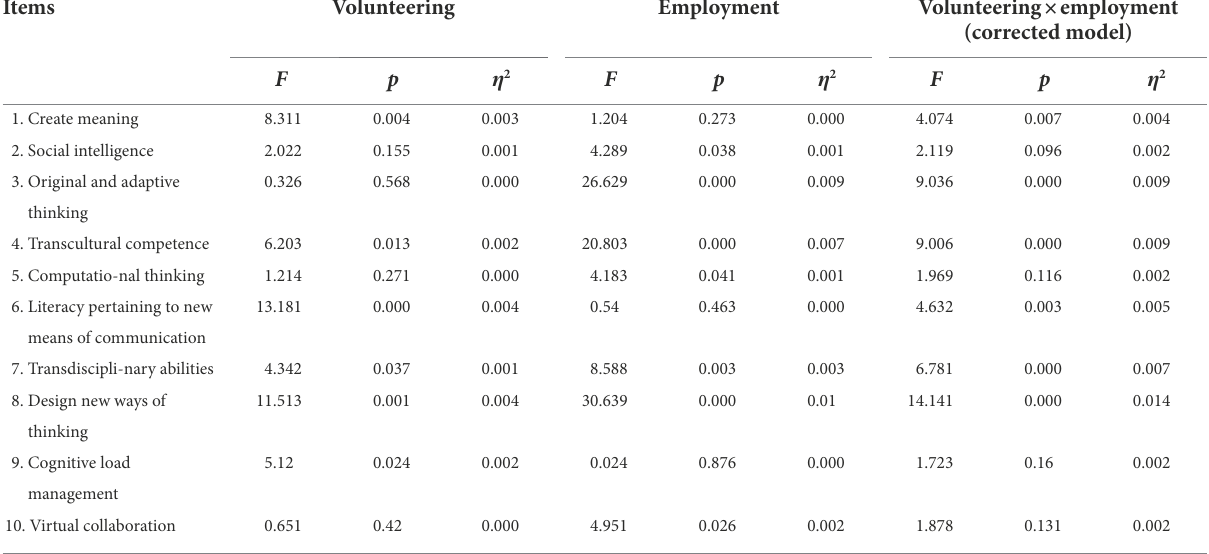
TABLE 1 Analysis of variance (ANOVA) and effect size ( η 2 ) outcomes regarding perceptions of future work skills as a function of being in employment or volunteering. Items